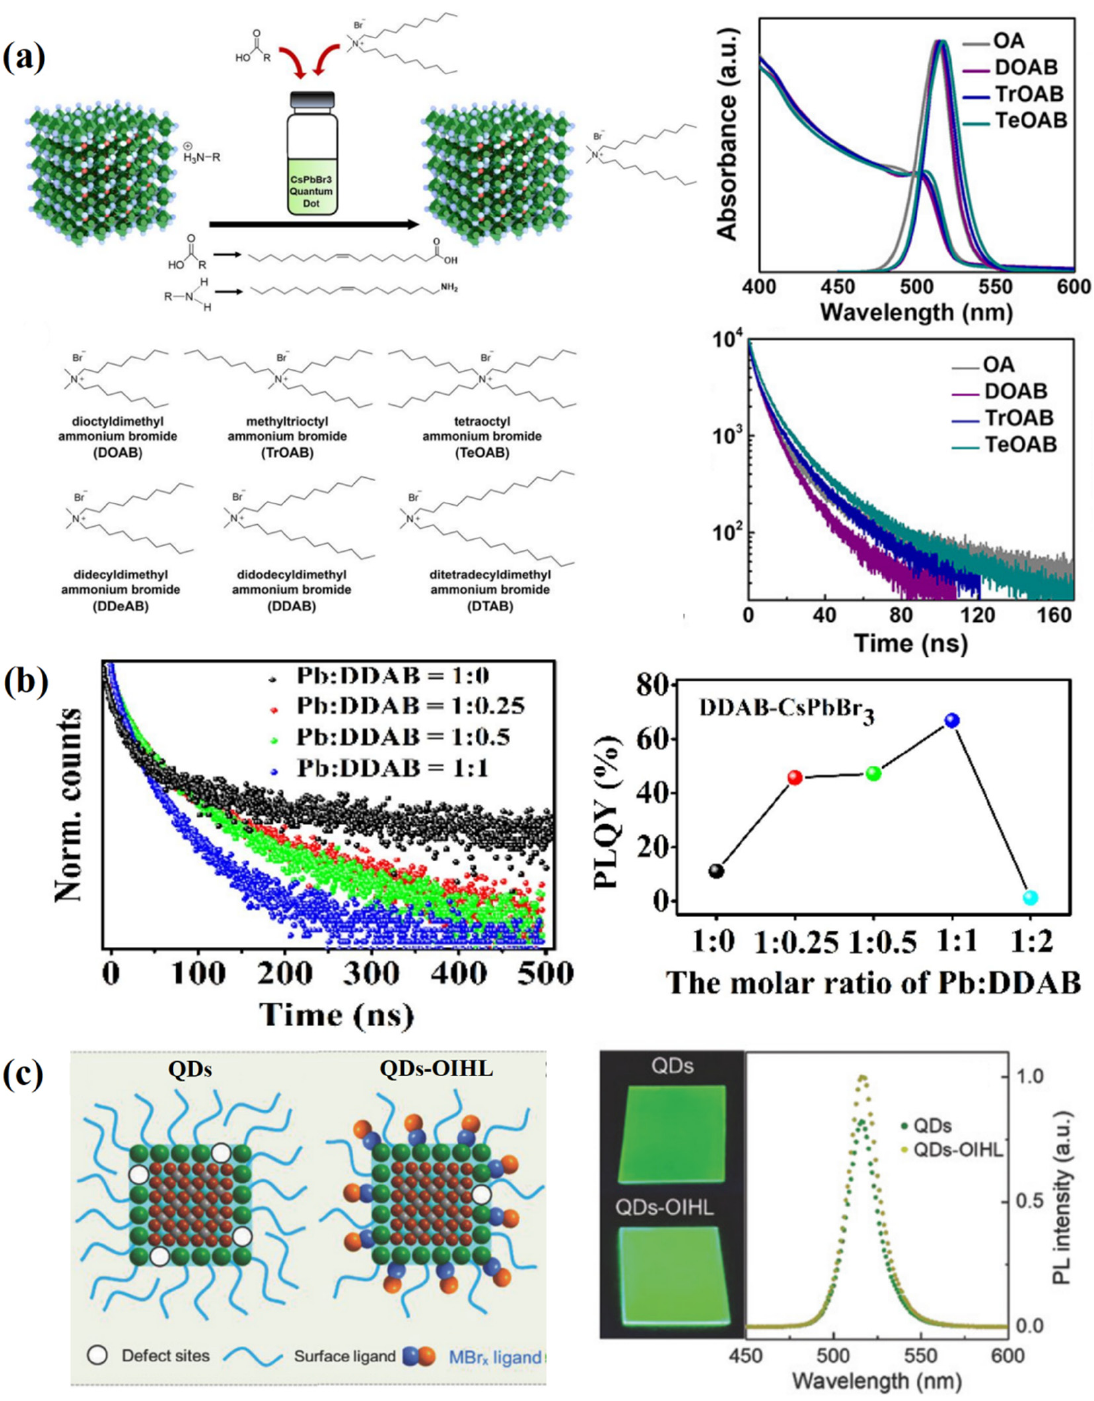
Figure 6. ( a ) Quaternary ammonium bromide ligand materials with different bulkiness and length. Adapted with permission from [78]. Copyright 2019, American Chemical Society. ( b ) PLQY and PL decay curves of DDAB-CsPbBr 3 QDs with different molar ratios of Pb: DDAB. Reproduced with permission from [80]. Copyright 2021, ELSEVIER. ( c ) OIHL passivation strategy for IPQDs. Reproduced with permission from [82]. Copyright 2018,